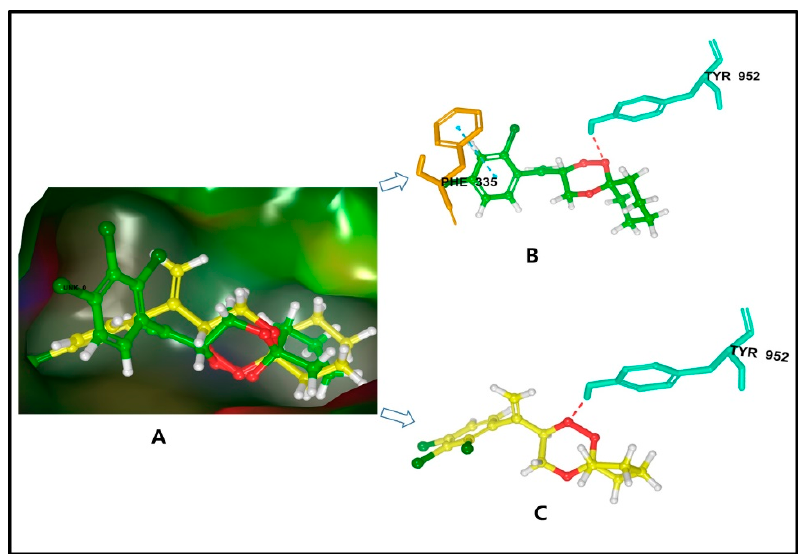
Figure 9. ( A ) Superposition of docked pose; the binding site amino acid residues interactions within 3Å is shown only for ( B ) 7 and ( C ) 8 .